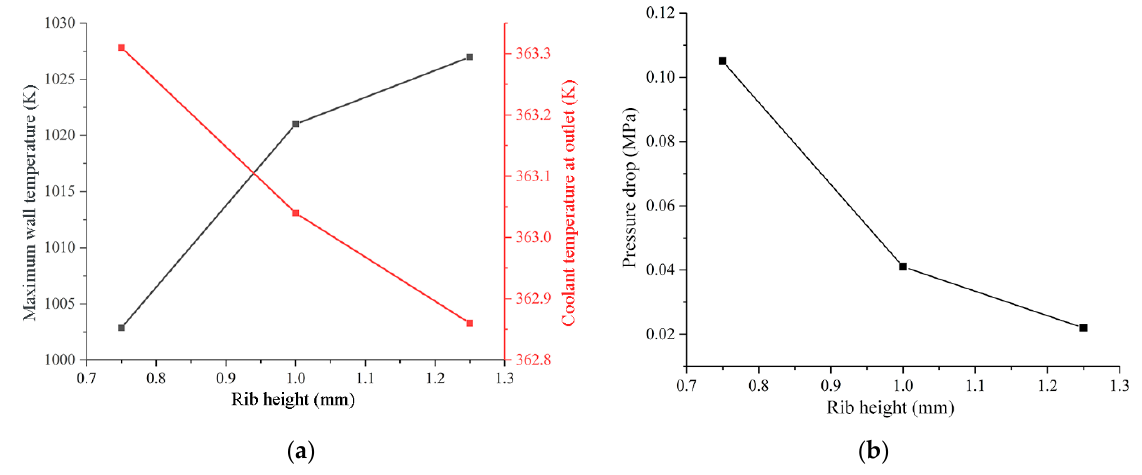
Figure 15. Temperature and pressure drop at different rib heights. ( a ) Wall temperature and coolant temperature; ( b ) pressure drop at different rib heights.